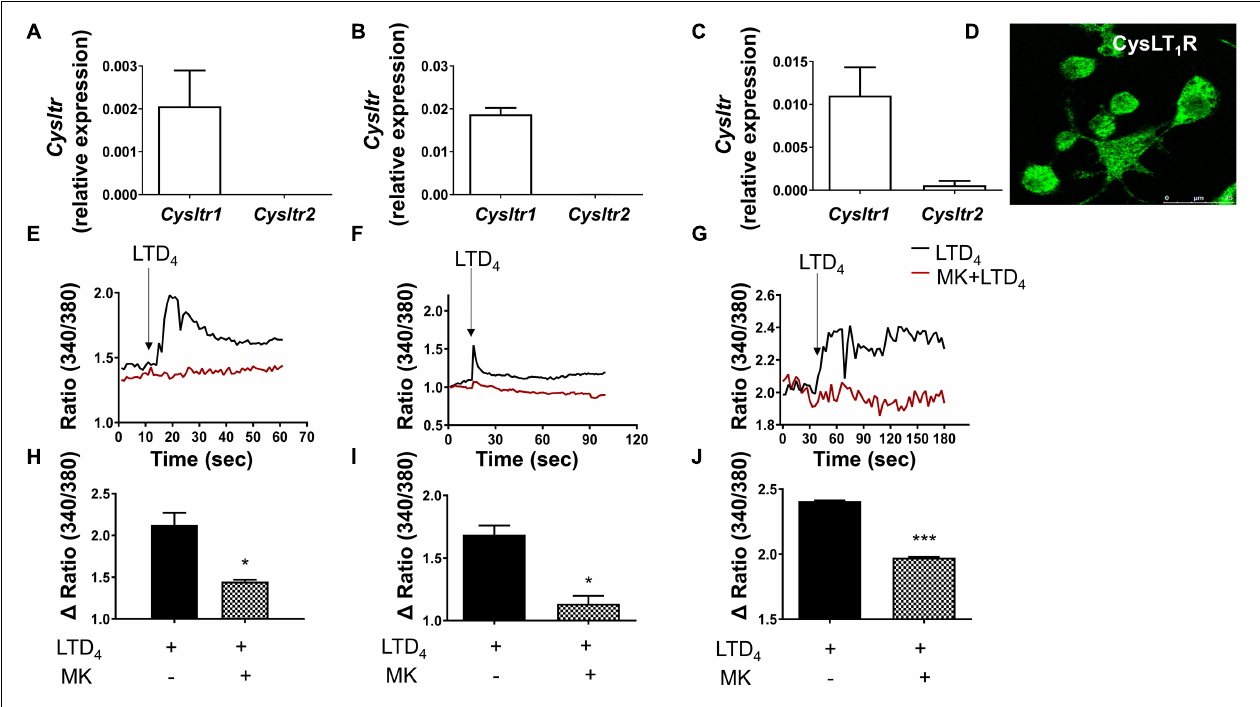
FIGURE 1 | Cys-LTs induce calcium flux in macrophages through CysLT 1 R. The expression of CysLT 1 R and CysLT 2 R transcript was analyzed in (A) raw macrophages, (B) THP-1-derived macrophages, and (C) BMDMs by qPCR. (D) Immune-staining of raw macrophages for CysLT 1 R expression. Macrophages were loaded with Fura-2-AM, stimulated with LTD 4 (0.5 µ M), and then calcium flux was measured in (E) raw macrophages, (F) THP-1-derived macrophages, and (G) BMDM in the presence or absence of CysLT 1 R antagonist MK. Panels (H–J) represent quantification of data from panels (E–G) , respectively. The results shown are mean ± SEM from three independent experiments (Student’s t -test, * p ≤ 0.05 and *** p ≤